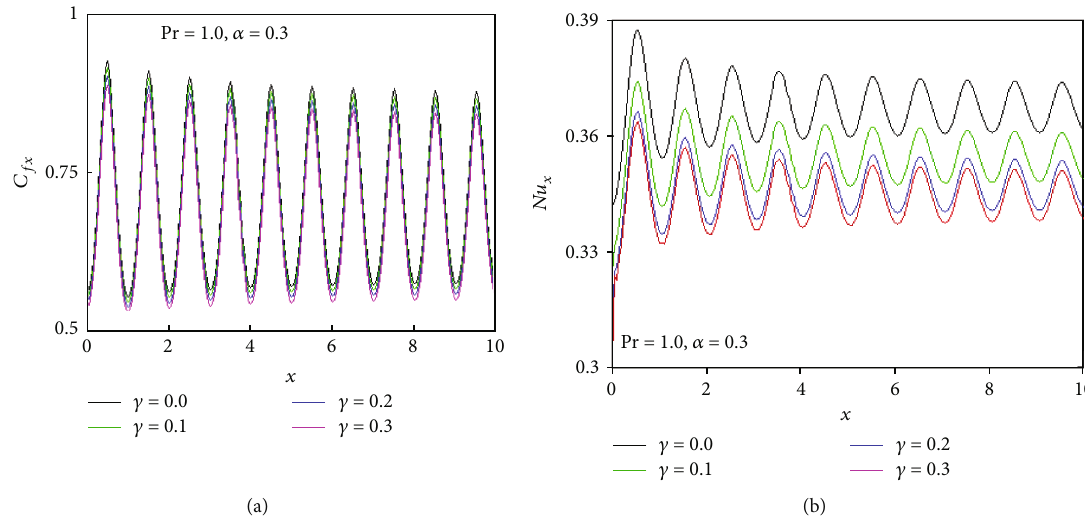
Figure 2: Variety of (a) C , frictional coe ffi cient of skin, and (b) Nu fx various thermal conductivity values while Pr = 1 : 0 and α = 0 : 3 .